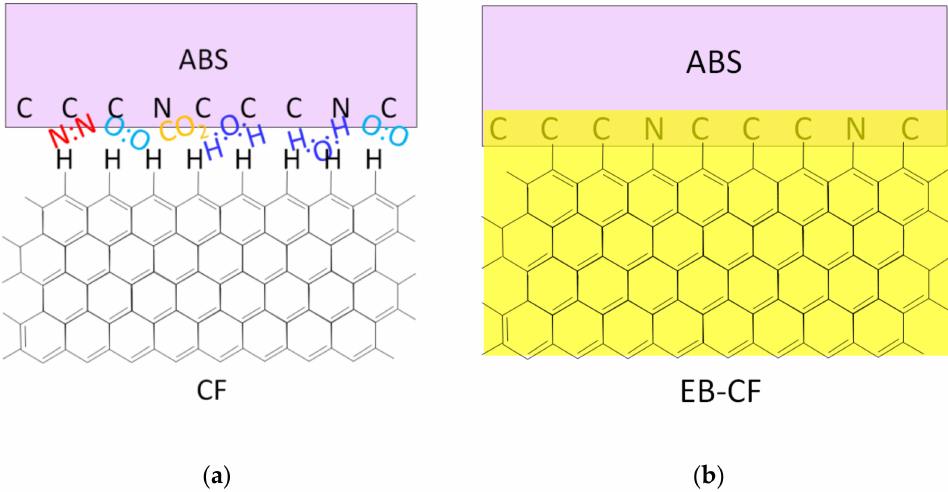
Figure 6. Schematics of ( a ) untreated CF and ( b ) HLEBI-treated CF with ABS thermoplastic. HLEBI activation area is in yellow. Not drawn to